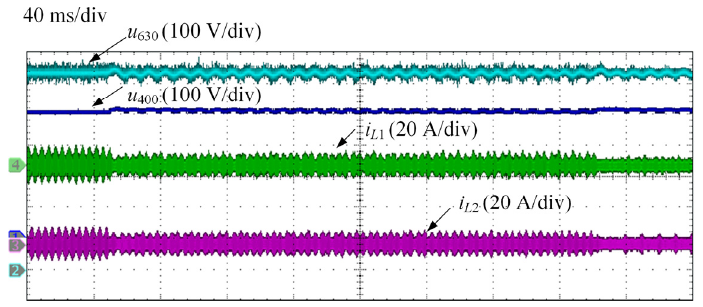
Figure 22. Waveforms of AC load transition from 7 kW to 2.3 kW to 0 in off-line mode.